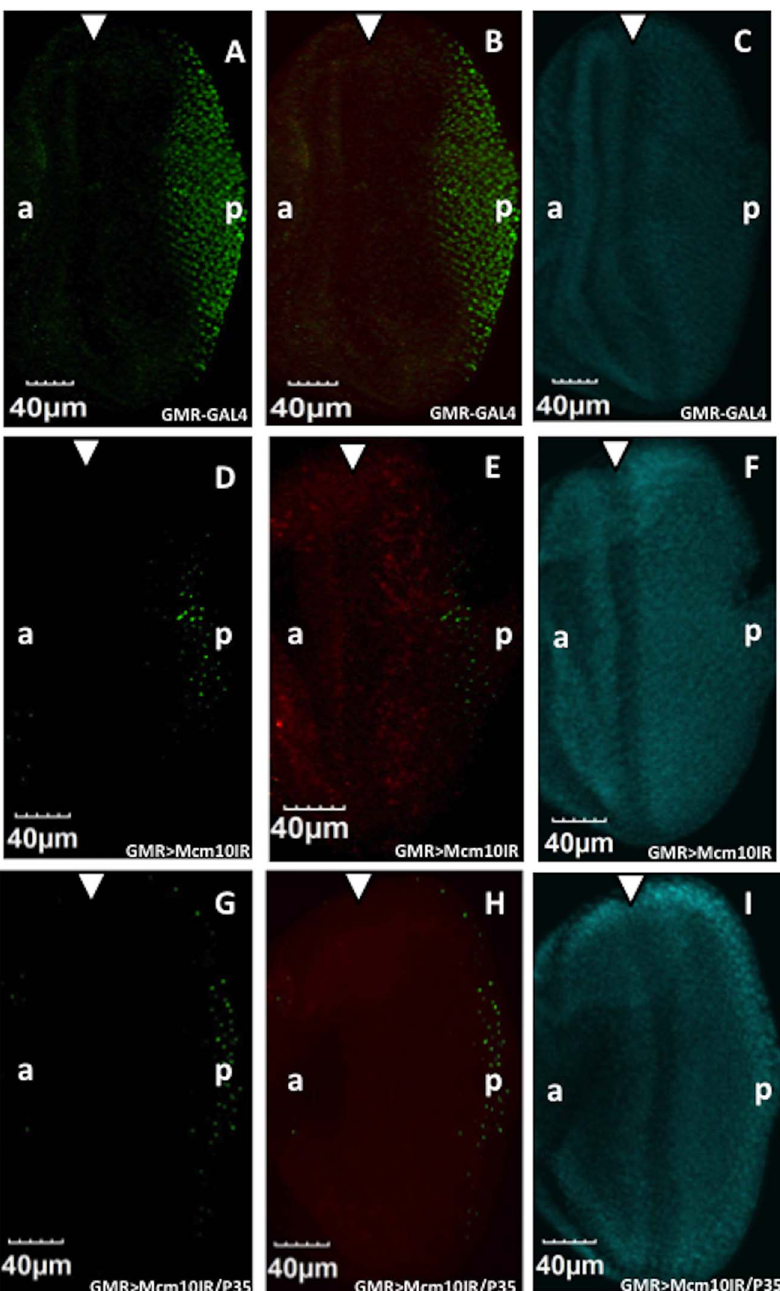
Figure 10. Knockdown of dMcm10 in eye imaginal discs inhibits R7 photoreceptor cell differentiation independently of its apoptotic effect. The eye imaginal discs of third instar lavae were stained with anti-Prospero antibody (Green) (A, D, G). Merged images were generated of eye discs staining with anti-Prospero antibody (Green) and anti-cleaved caspase-3 antibody (Red) (B, E, H). Images of eye discs staining DNA with DAPI (Blue) (C, F, I) are also shown. (A, B, C) shows GMR -GAL4/ yw ; + ; + ; (D, E, F) shows GMR -GAL4/ yw ; + ; UAS-d Mcm10IR 633-700 / + ; and (G, H, J) shows GMR - GAL4/ yw ; + ; UAS-d Mcm10IR 633-700 /UAS- P35 . White arrowhead shows morphogenetic furrow. Bars indicate 40 m m. The flies were reared at 28 u C.